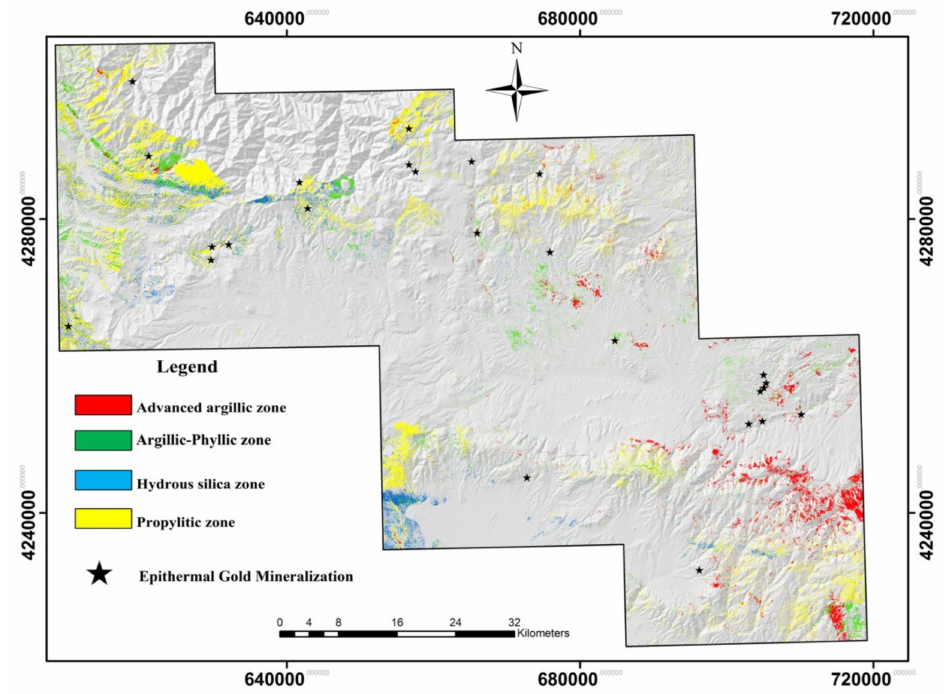
Figure 8. The RDB1(4 + 6 / 5), RDB2 (5 + 7 / 6), RDB3 (6 + 9 / 7 + 8) and RDB4 (5 + 8 / 6 + 7) of ASTER shows advanced argillic, argillic-phyllic, propylitic and hydrous silica-a ff ected alteration zones in the study area overlaid on hill